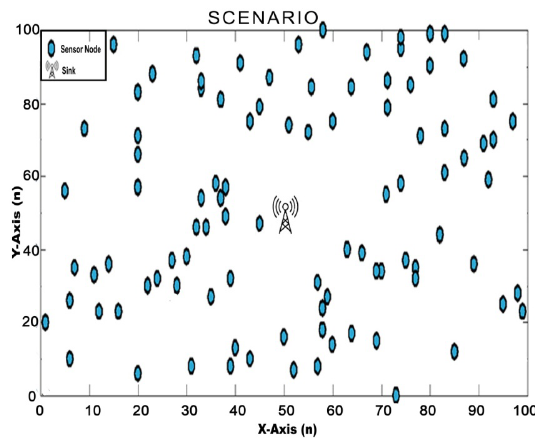
Figure 9. Comparison of various protocol in terms of First node die (FND), Quarter node die (QND), Half node die (HND) for N=100